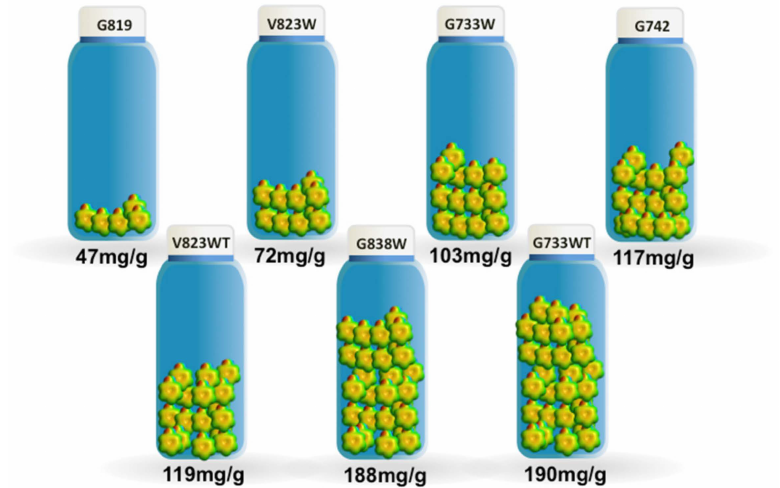
Figure 3. The maximum adsorption capacity for the phenol adsorption.